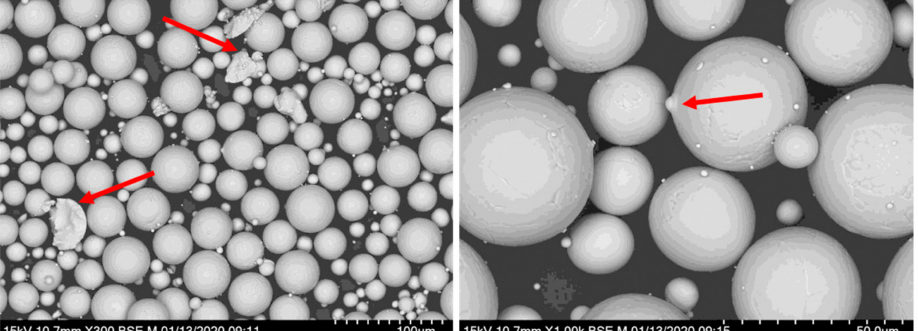
Figure 8. SEM images of powder samples after sieving and blending.